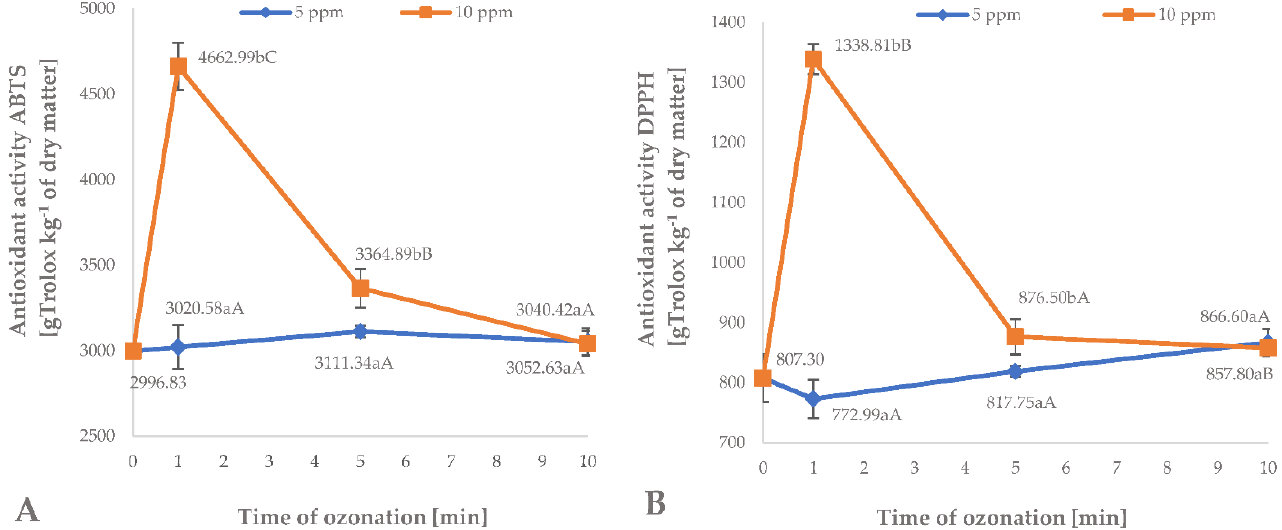
Figure 1. Antioxidant activity ABTS ( 2,2′ -Azino-bis-(3-ethylbenzothiazoline-6-sulfonic acid) test ( A ) and DPPH (2,2-Diphenyl-1-picrylhydrazyl) test ( B ) in Kalanchoe daigremontiana leaves depending on the duration of ozone treatment (n = 20): differences between the results for duration of ozone treatment on specific days are marked with small letters, and differences between dose of ozone (ppm) measurement are marked with capital letters; significance level is defined as p < 0.05.